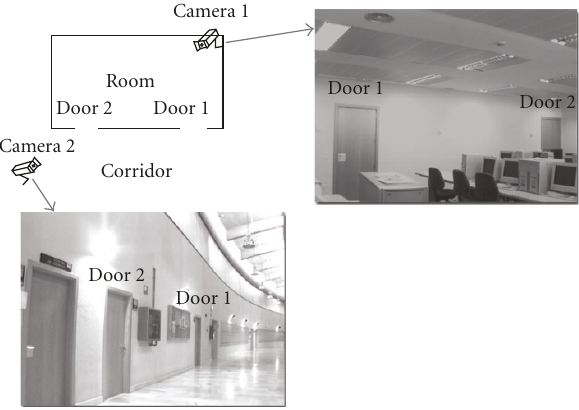
Figure 7: Indoor scenario. There are two camera-agents; one (camera 1) is guarding a room with two doors and the other (camera 2) is placed outside the room, in a